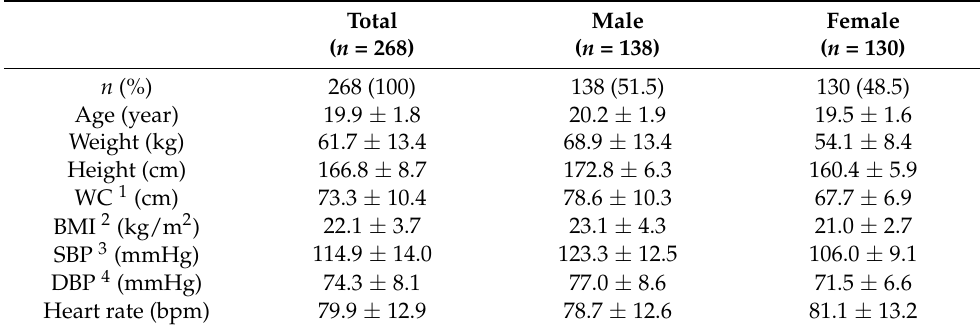
Table 1. Characteristics of participants by